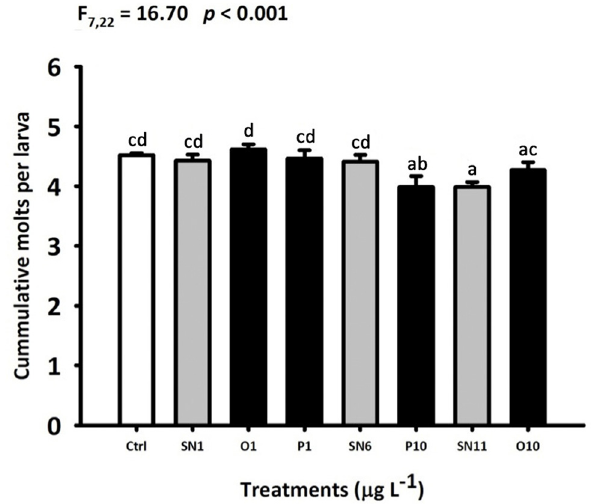
Fig 4. Effect of OAgNPs, PAgNPs and AgNO 3 on the cumulative molts per larva of B . amphitrite on Day 5. Each bar represents the mean (+ SD) of four replicates. One-way ANOVA was used for the statistics analysis. Different letters above the bar indicate the means that are significantly different as identified by Tukey ’ s test. Ctrl: FSW control, SN: AgNO 3 , O: OAgNP and P: